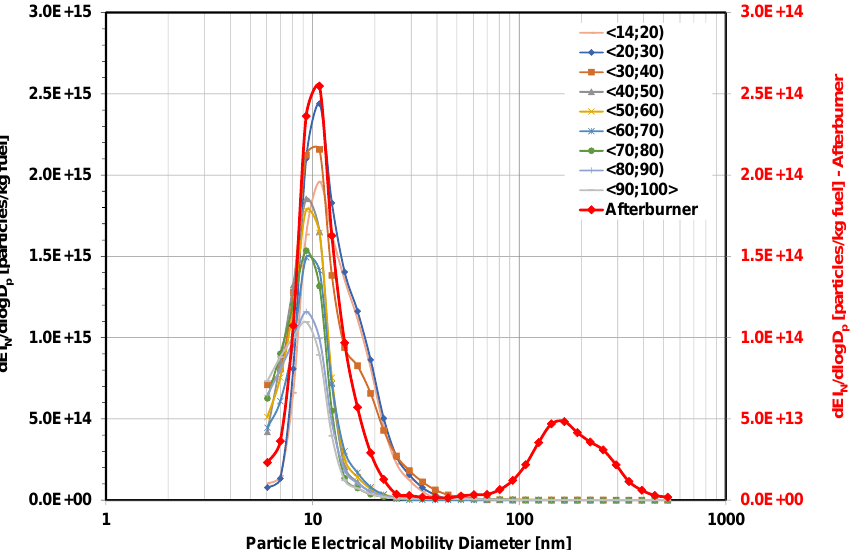
Figure 3. Differential Particle Number Emission Index (EI N ) PSD for the entire range of engine operation and the afterburner.